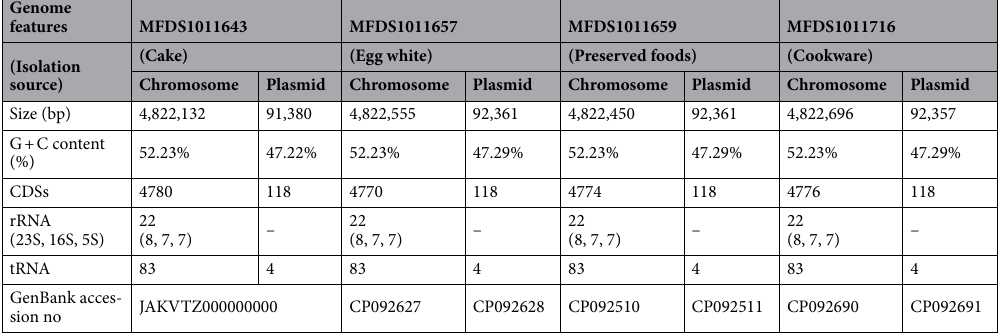
Table 1. Genomic properties of Salmonella enterica serovar Thompson isolates from the chocolate cake- related outbreak in South Korea, 2018. CDS Coding sequence, rRNA Ribosomal ribonucleic acid, tRNA Transfer ribonucleic